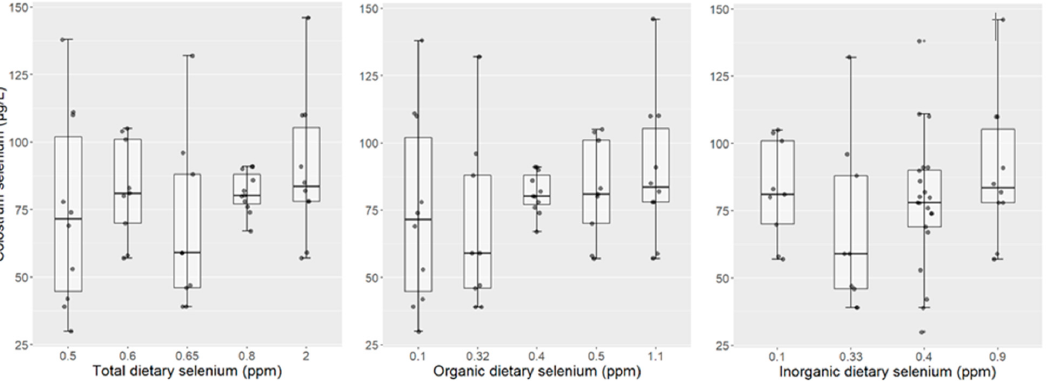
Figure 4. Boxplots and ANOVA results for colostrum selenium concentration vs. dietary selenium levels. Total dietary selenium = organic and inorganic dietary selenium. In the three cases, all ANOVAs were not significant (all means were equal).